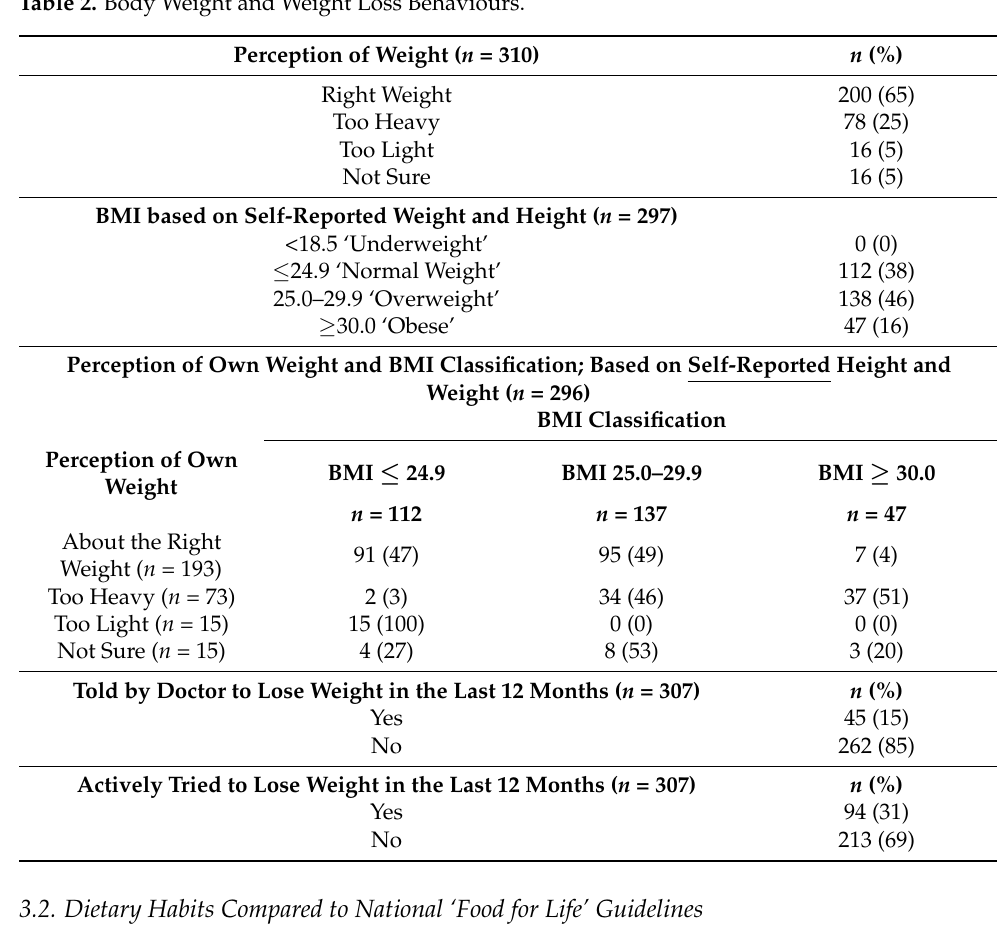
Table 2. Body Weight and Weight Loss Behaviours.